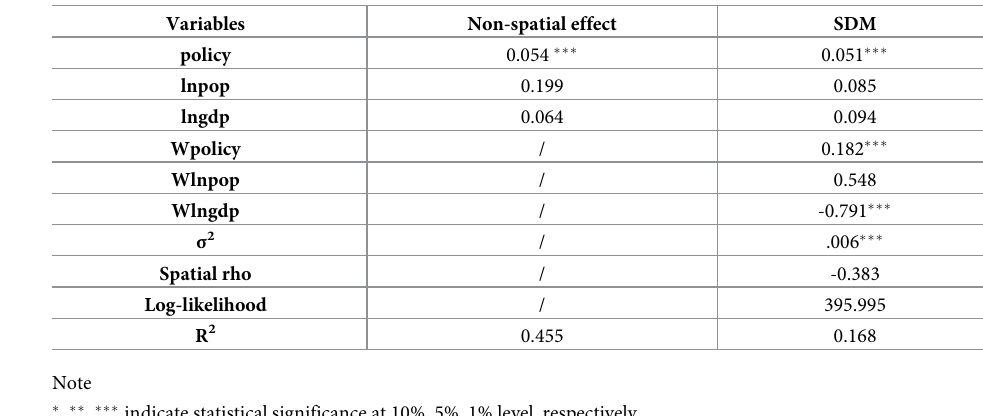
Table 5. Comparison of empirical results of housing price spatial panel